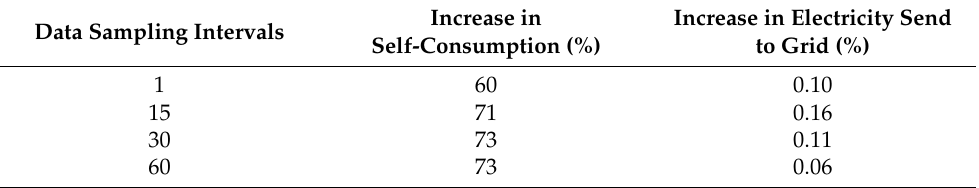
Table 3. Increase in self-consumption when using SC in the HKT/On grid renewable system.